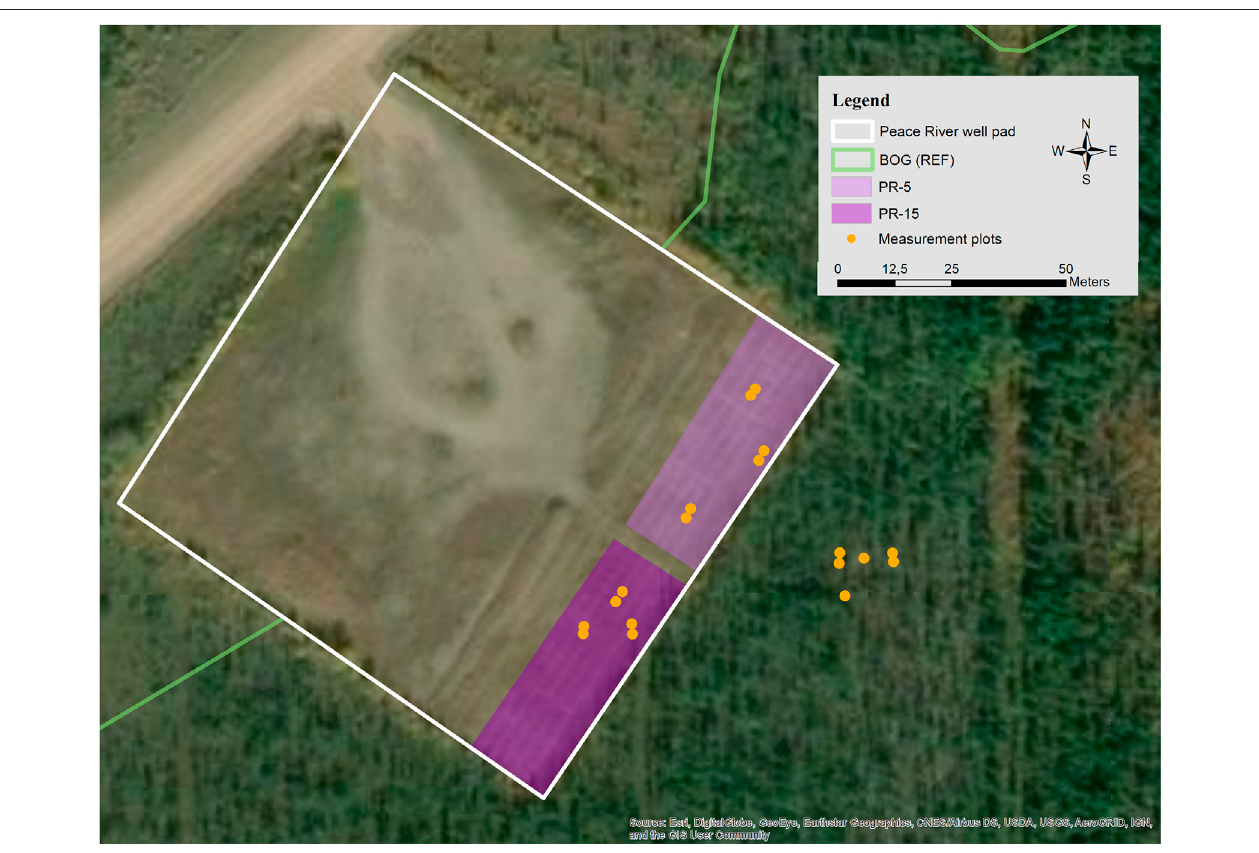
FIGURE 2 | The Peace River well pad (white outline) is located within a wooded bog ecosystem, which serves as reference ecosystem (BOG) in this study. In two restored sectors of the well pad, the mineral soil was partially removed (PR) to 15 cm (PR-15) and to 5 cm (PR-5) above the water table of the adjacent peatland. Yellow dots indicate measurement